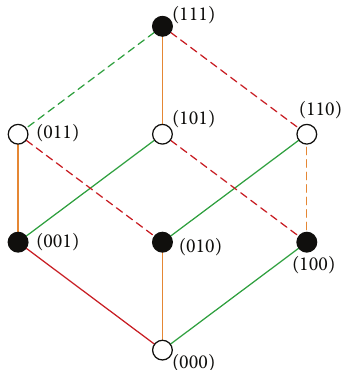
Figure 3: A 3-cube Adinkra shown together with a codeword representation for each